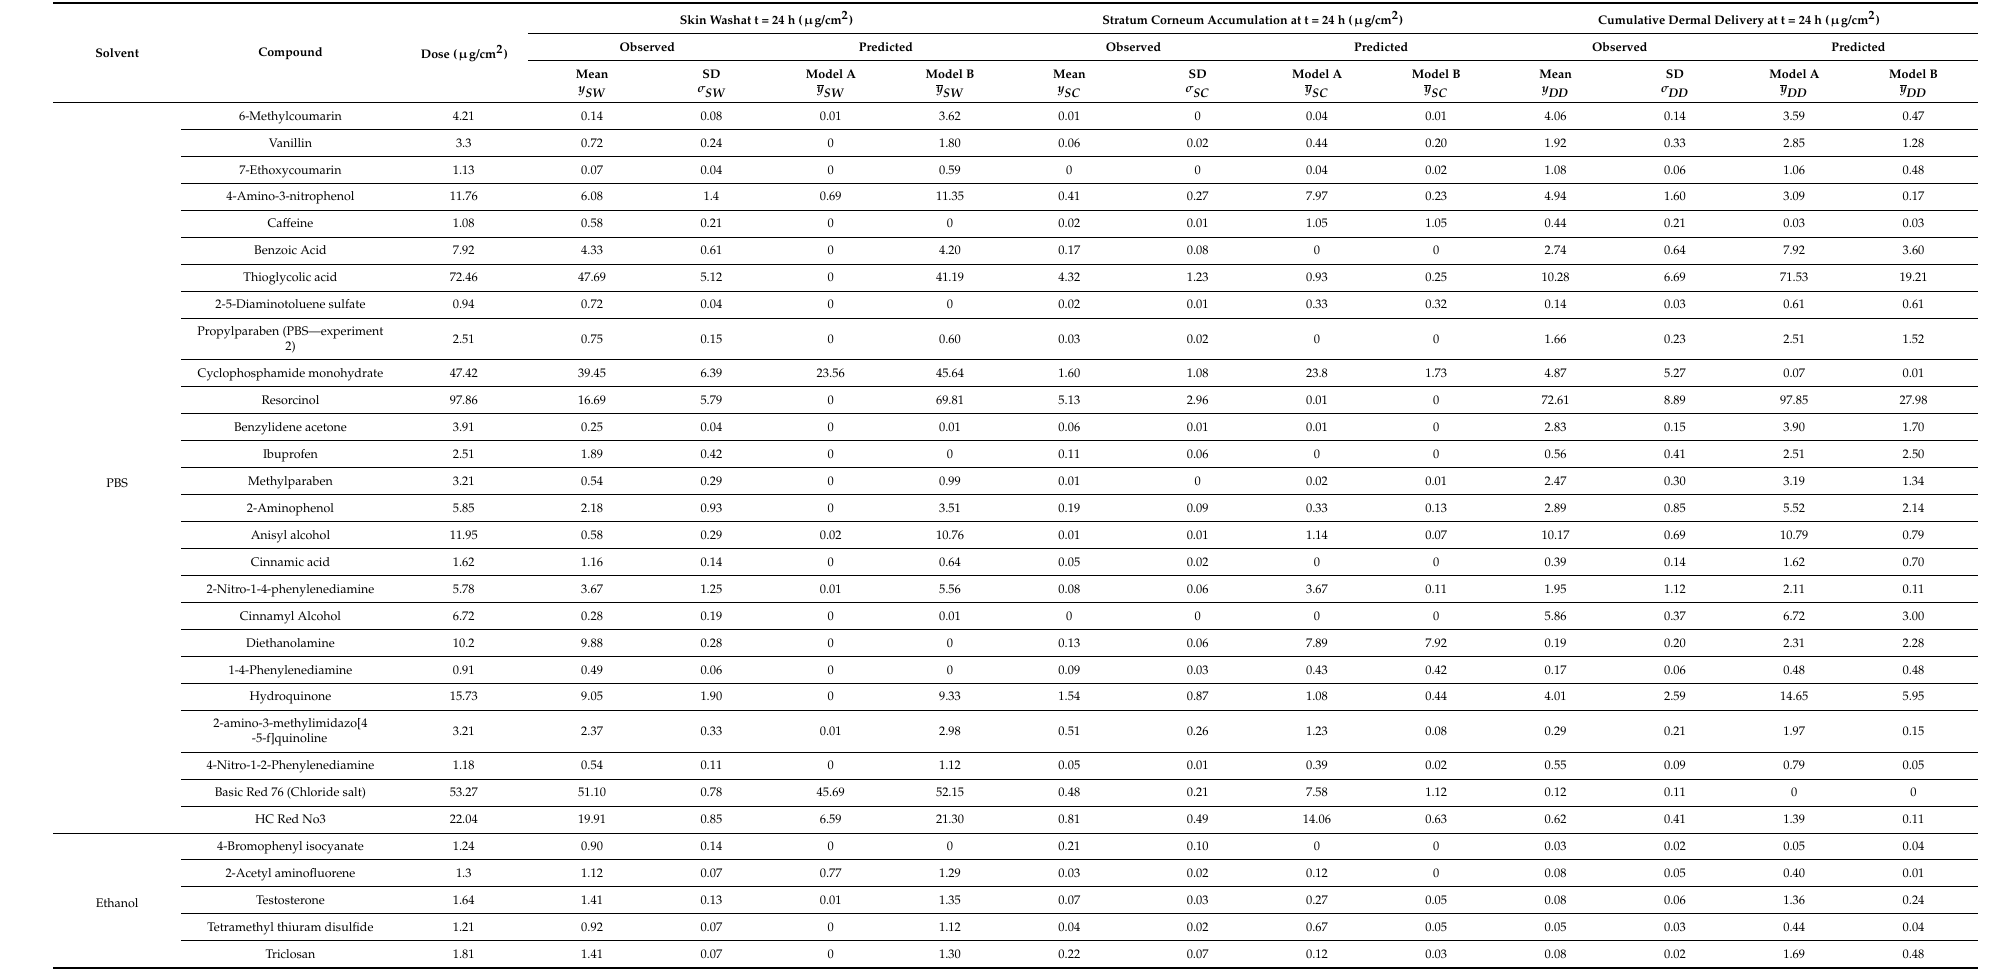
Table 4. Summary of measurements from Hewitt et al. [5] and simulations of Models A and B of skin wash, SC accumulation and dermal delivery at 24 h for IVPTs selected for model